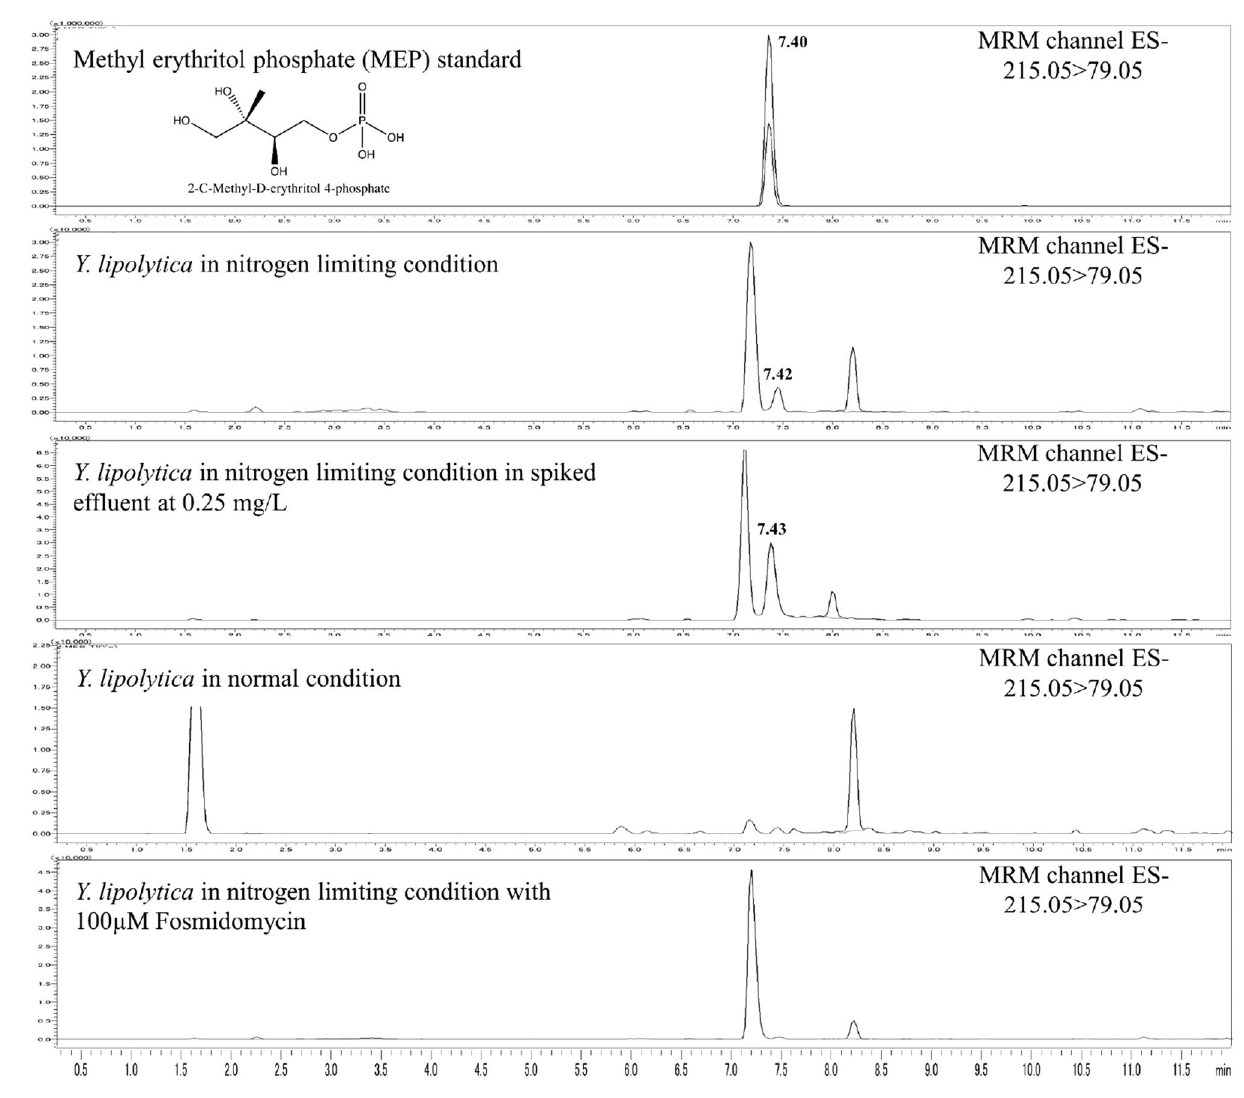
Figure 2. LC/QqQ/MS analysis results; Multiple reaction monitoring (MRM) chromatograms of methyl erythritol phosphate (MEP) standard, Y. lipolytica in nitrogen limiting condition, Y. lipolytica in nitrogen limiting condition in spiked effluent at 0.25 g/L, Y. lipolytica in normal condition and Y. lipolytica in nitrogen limiting condition cultivated with 100 µM